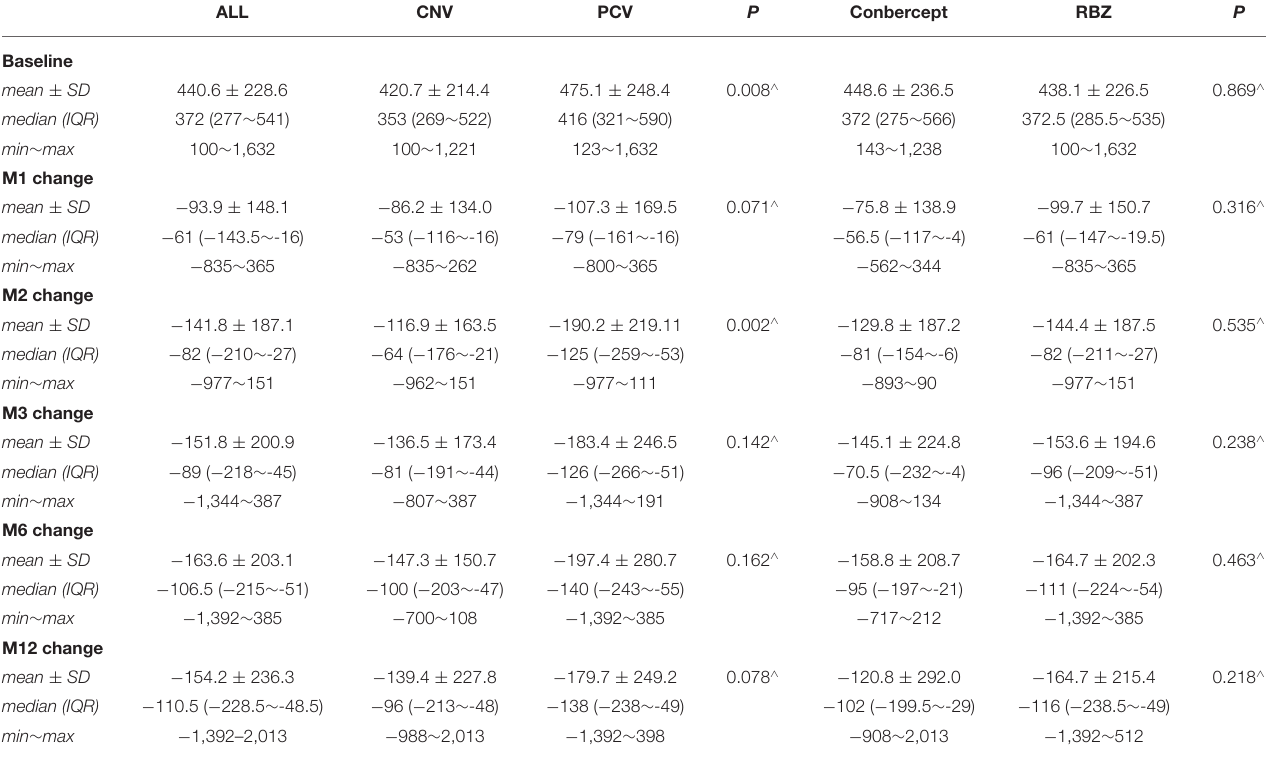
TABLE 4 | Mean CRT changes compared with baseline ( µ m).